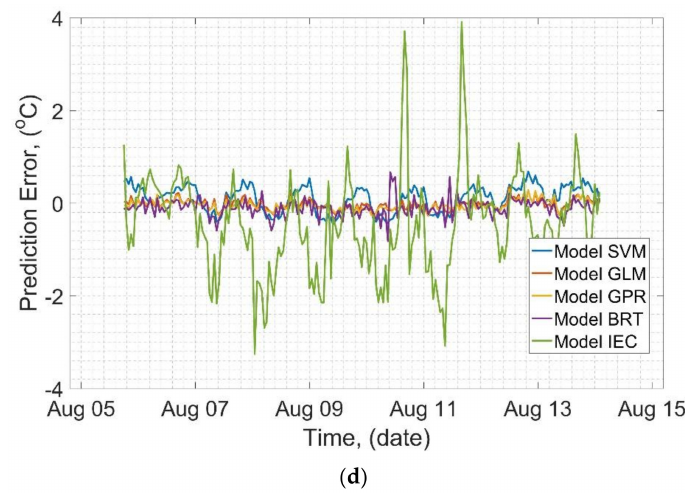
Figure 8. Exemplary results of HS modeling in Tr1 for all models. Summer: ( a ) temperature runs of HV winding, ( b ) errors of models for HV winding, ( c ) temperature runs of LV winding, ( d ) errors of models for LV